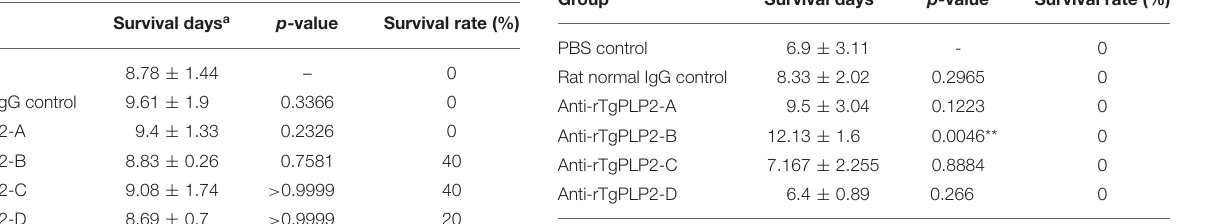
TABLE 1 | Survival days of BALB/c mice challenged intraperitoneally with 10 2 tachyzoites pretreated with anti-rTgPLP2 antibodies.